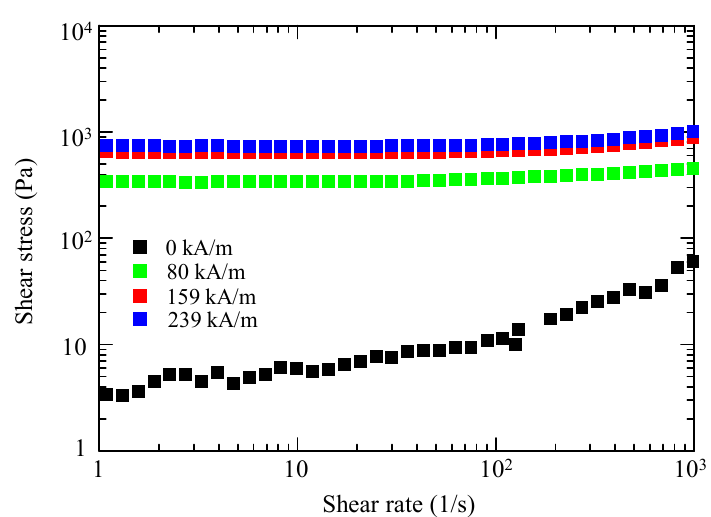
Figure 6. Flow curves under the magnetic fields for a Fe 3 O 4 suspension (10 vol. %) containing octahedral particles.